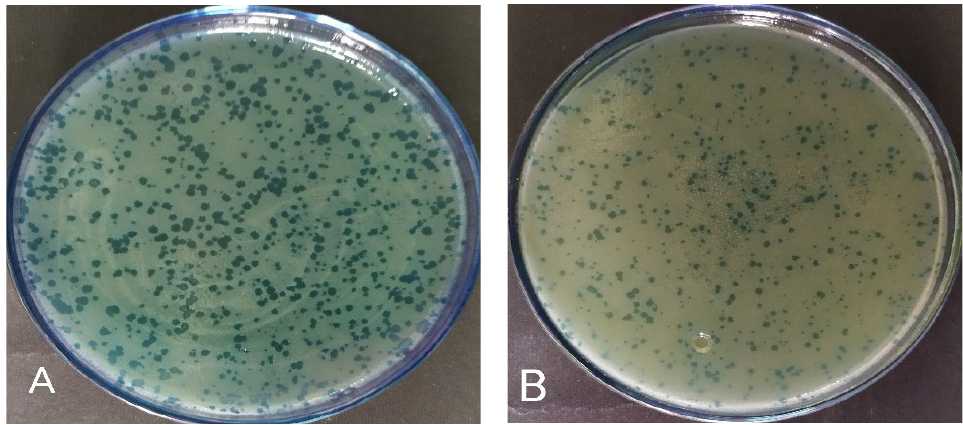
Figure 1. Plaques of phages ( A ) PB10 (10 7 PFU/mL) and ( B ) PA19 (10 7 PFU/mL) on P. aeruginosa ATCC27853 .